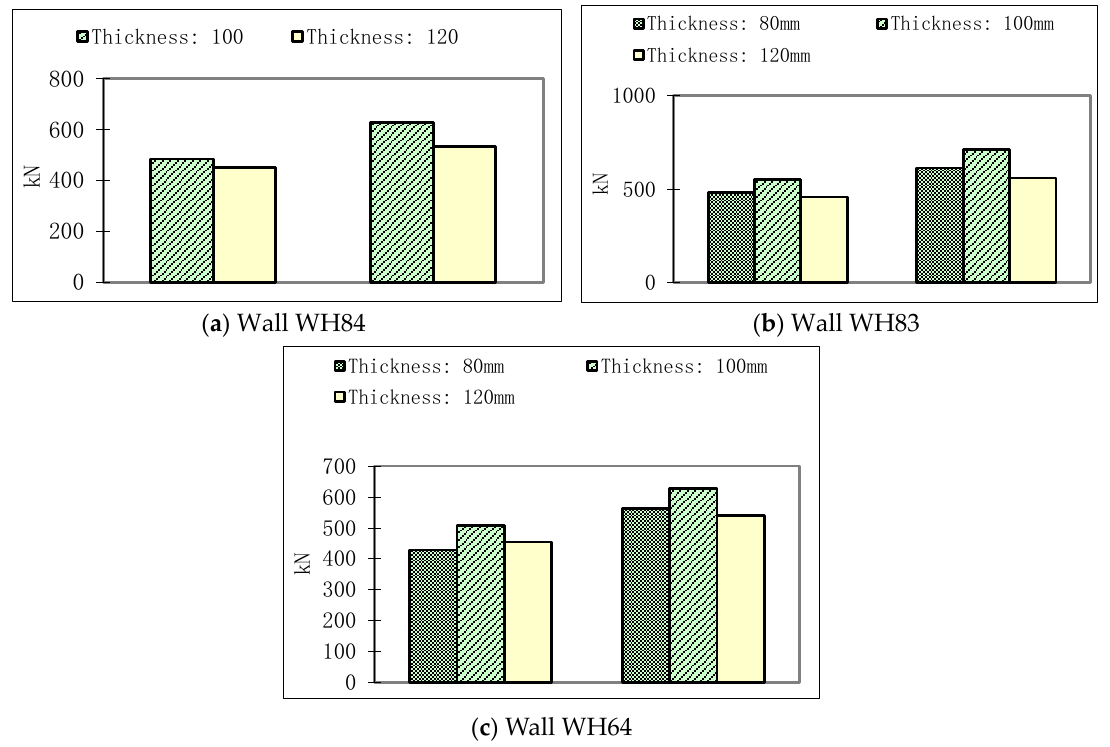
Figure 8. Comparison of the cracking load and ultimate load of walls with di ff erent thicknesses of insulating layers.